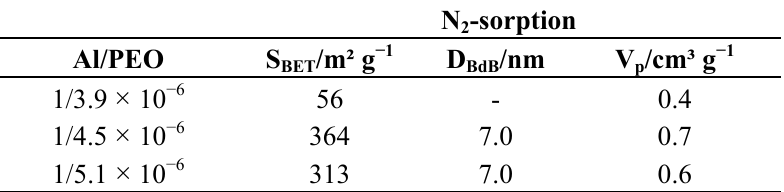
Table 1. Textural properties of alumina monoliths obtained with different Al/PEO ratios.